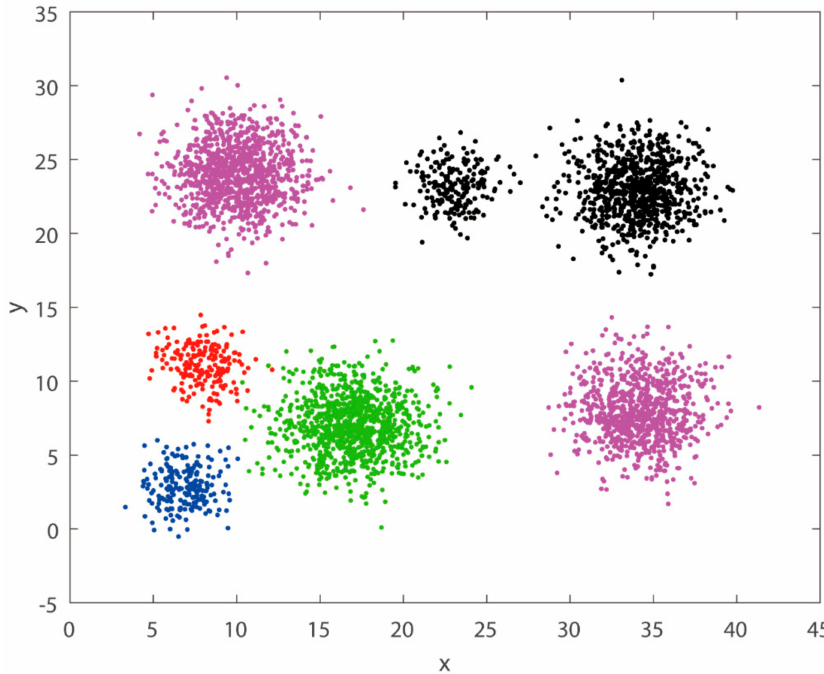
Figure 12. Dataset B ciphertext clustering